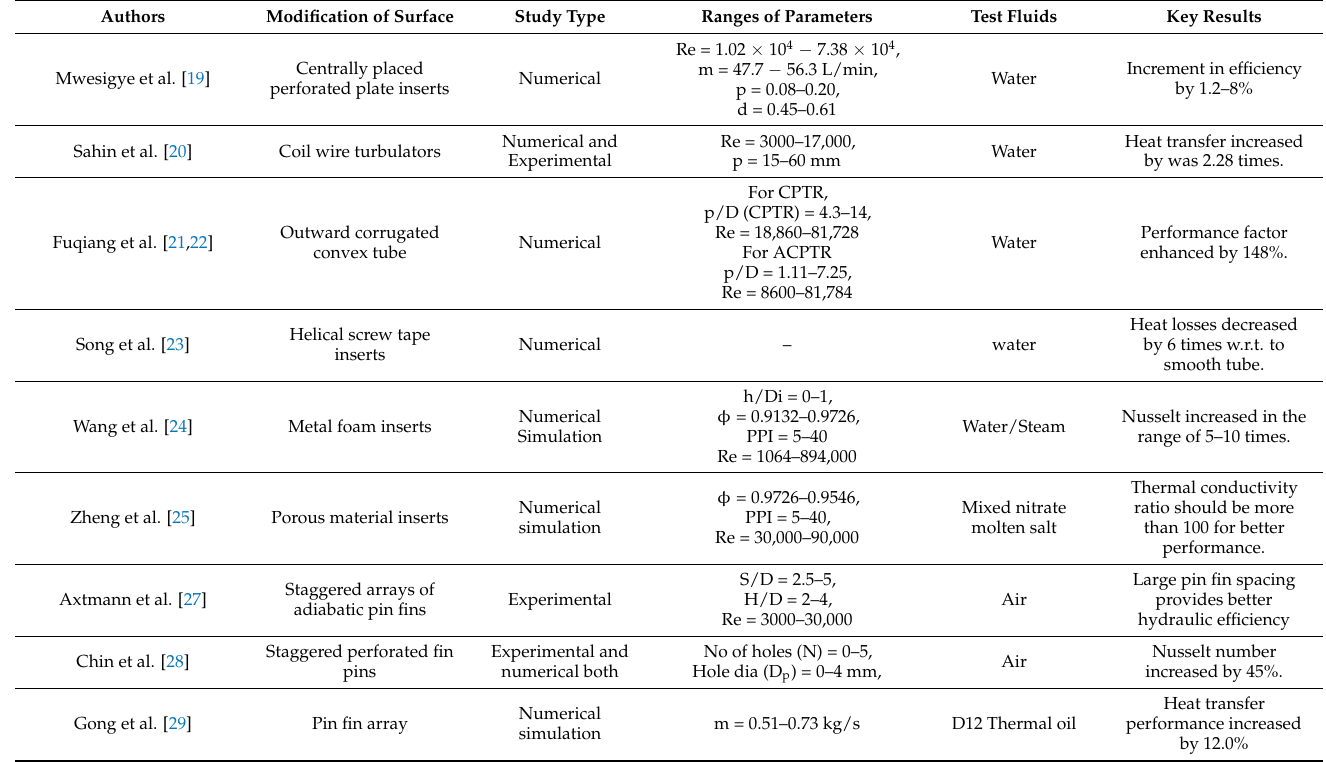
Table 2. Selective study on the surface modification of the absorber